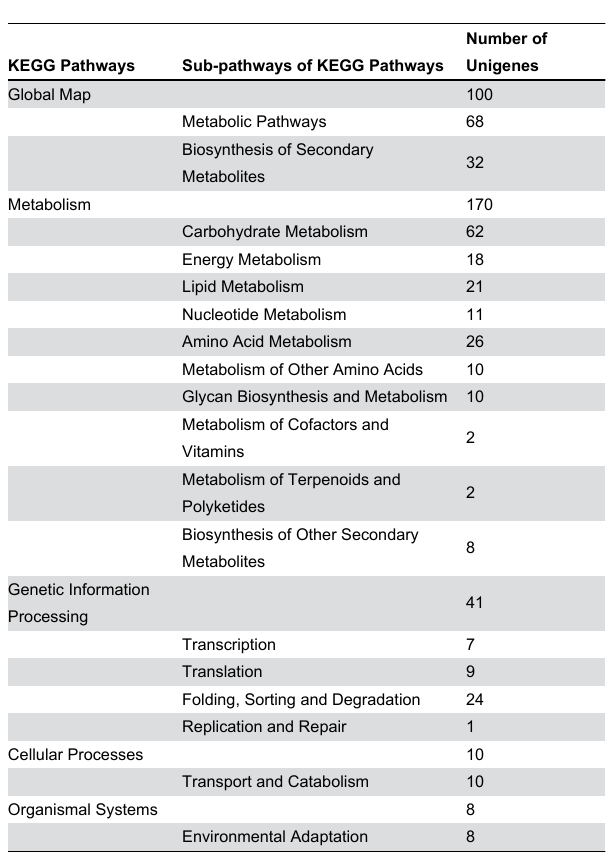
Table 1. Unigenes mapped in KEGG pathways.